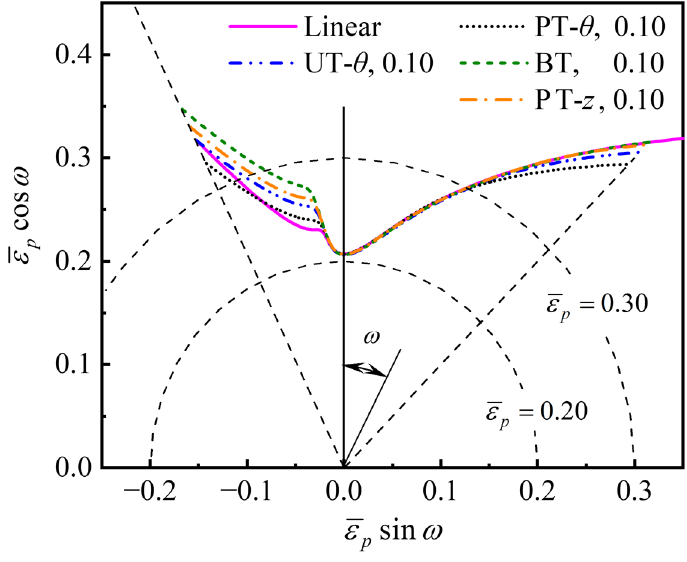
Figure 11. Predicted PEPS-FLD of the AA6061 tube under different pre-strain conditions. Then, the PEPS-FLC predicted by the M-K+DF2012 model under linear loading conditions is compared with the experimental results under linear paths and nonlinear paths A and B, as shown in Figure 12. The two experimental points of nonlinear loading are on the right-hand side, and all the points on the right-hand side roughly follow the same curve. It indicates that the path dependence of the PEPS-FLD of the AA6061 tube on the right-hand side is weak. In other words, the small difference between the predicted curves on the right-hand side of Figure 11 is consistent with the experimental phenomenon.